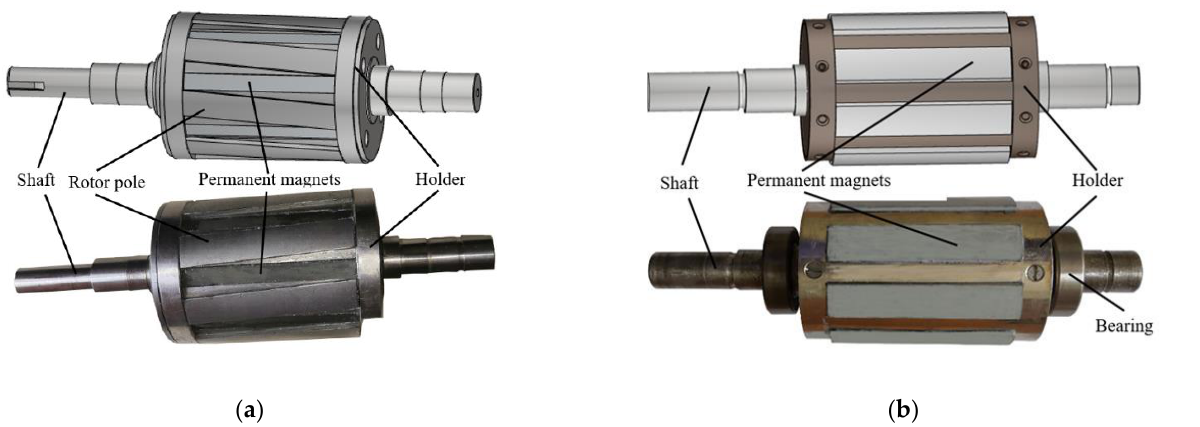
Figure 11. 3D FEM model of the PM rotor, and the photograph of its physical prototype. ( a ) Tangential rotor, ( b ) radial rotor .